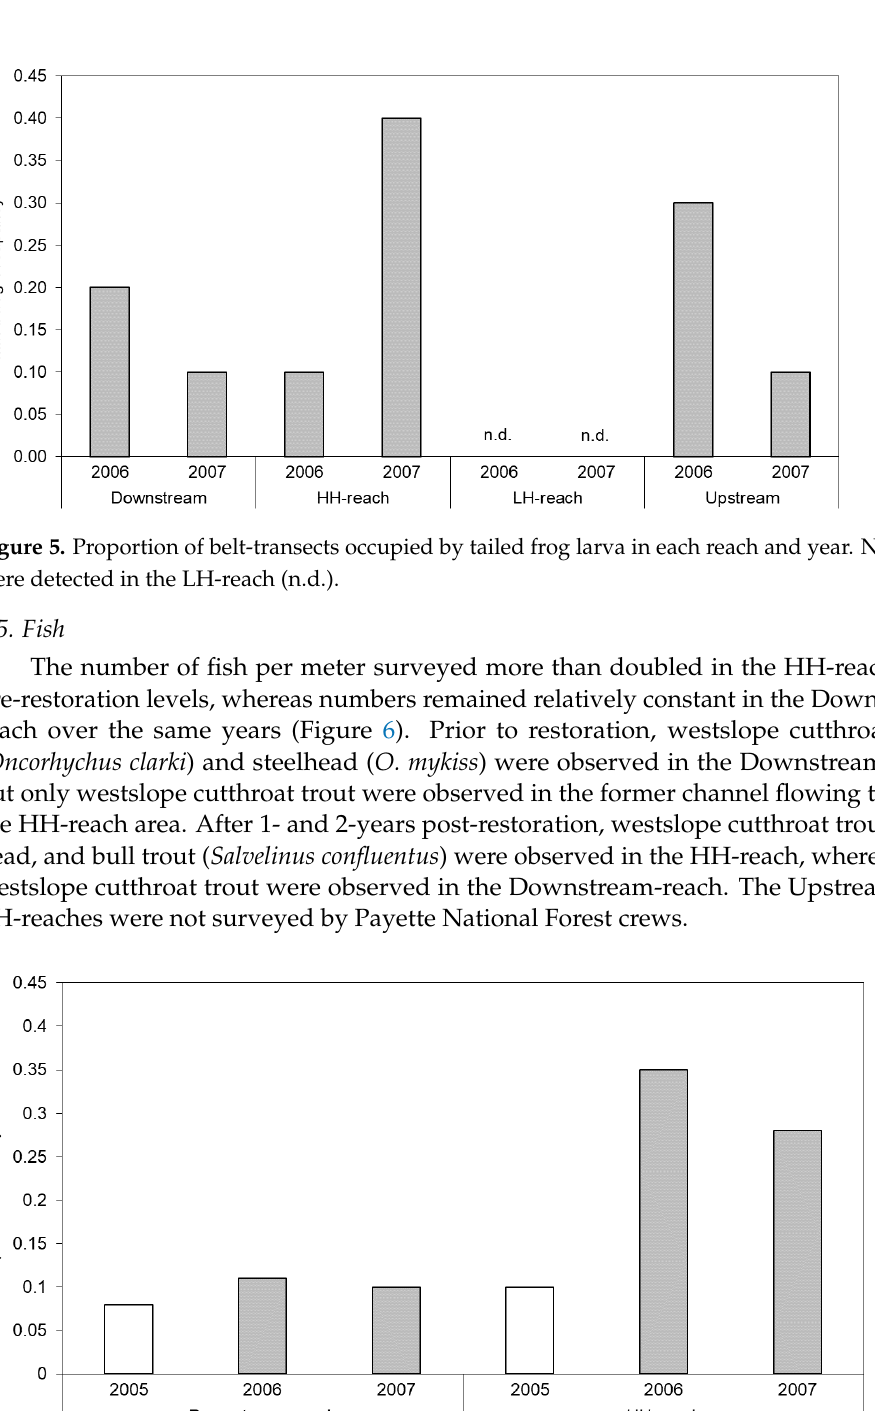
13 of 26 Figure 4. Nonparametric multiplicative regression (NPMR) modeled Chironomid- Nostoc mutualist density versus current velocity and light availability. Model is based on density data from 20 Surber samples collected in 2006 and explains 92% of the variation in the empirical data. 3.4. Amphibians In 2006, tailed frog larvae occupied 10% of transects in the HH- reach and no transects in the LH-reach (Figure 5). Occupancy rates were at least twice as high in the Downstream- and Upstream-reaches compared with the HH-reach. In 2007 however, the HH-reach had the